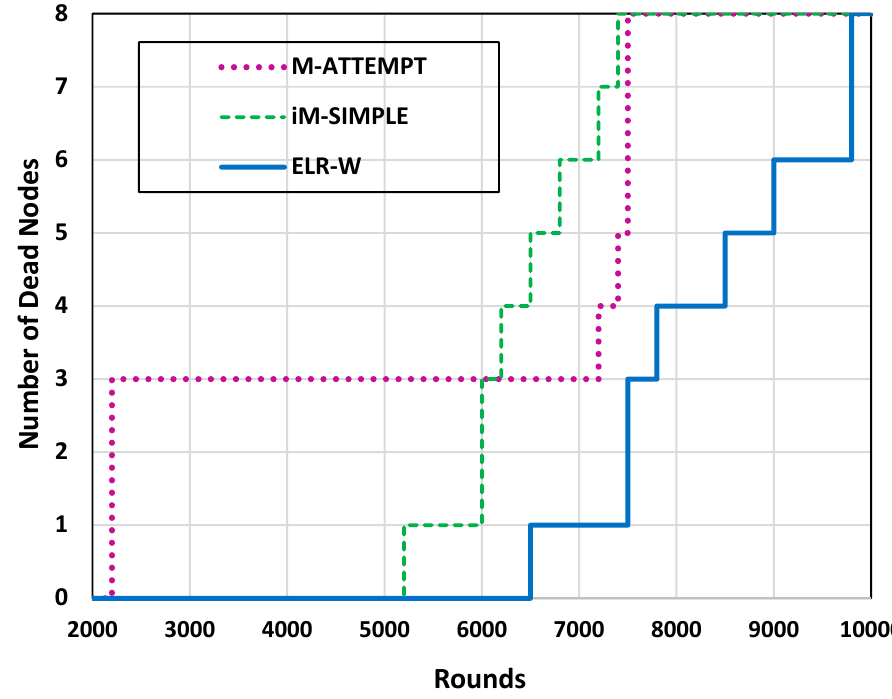
Figure 4. Analysis of network lifetime.